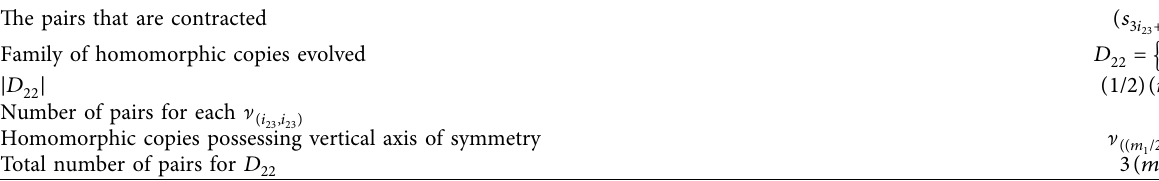
Table 22: Necessary information regarding homomorphic copies ]